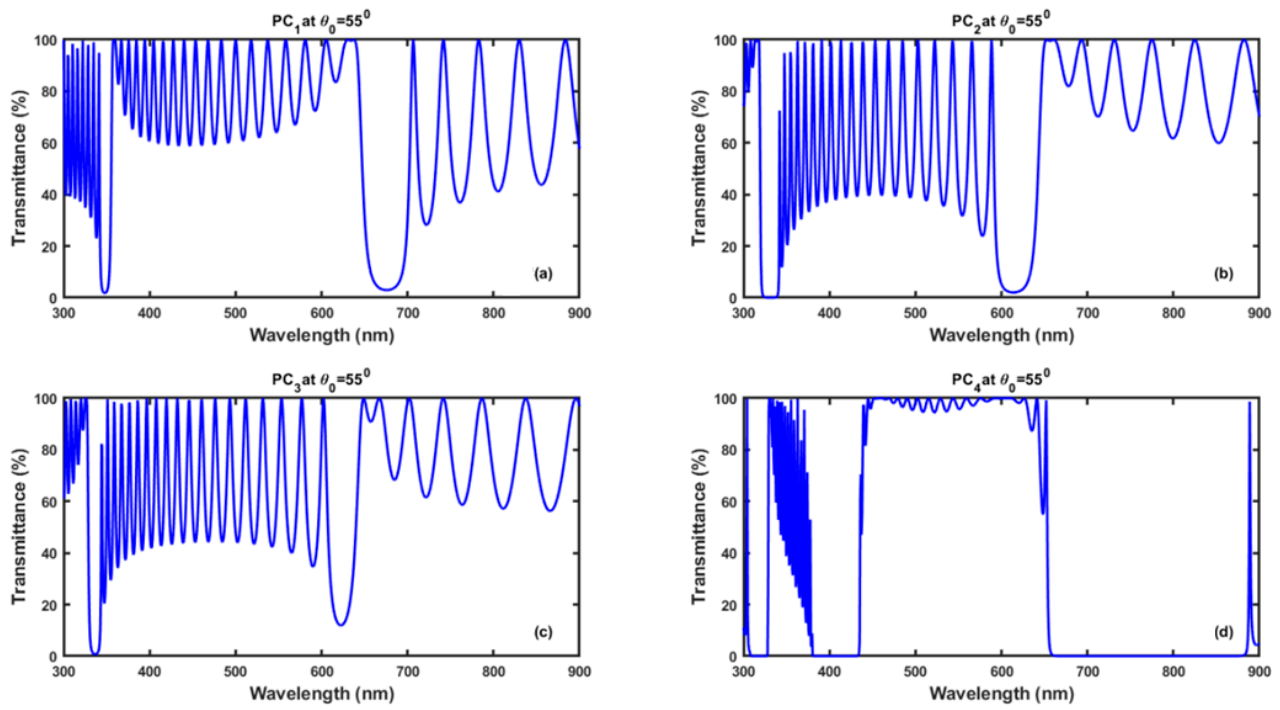
Figure 5. The calculated transmission spectra of 1D polycarbonate-based ternary photonic structures PC 1 , PC 2 , PC 3 and PC 4 as a function of wavelength at θ 0 = 55 ◦ are shown: ( a ) polycarbonate/Al 2 O 3 , ( b ) polycarbonate/MgF 2 , ( c ) polycarbonate/BaF 2 and ( d ) polycarbonate/TiO 2 .